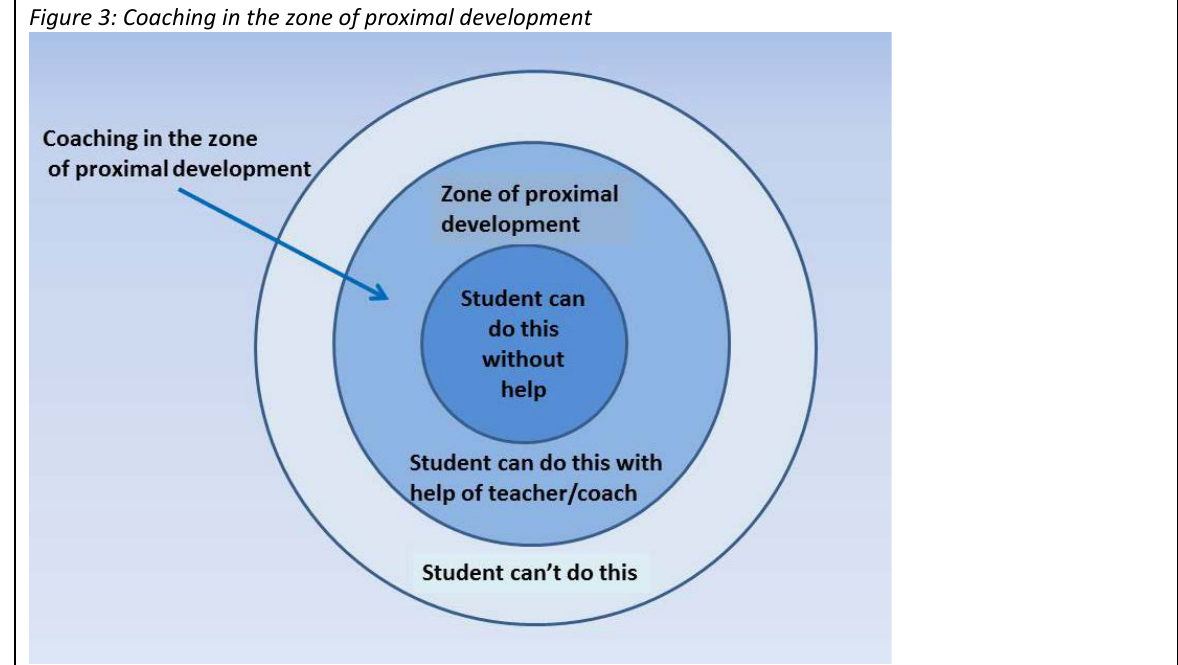
Figure 3: Coaching in the zone of proximal